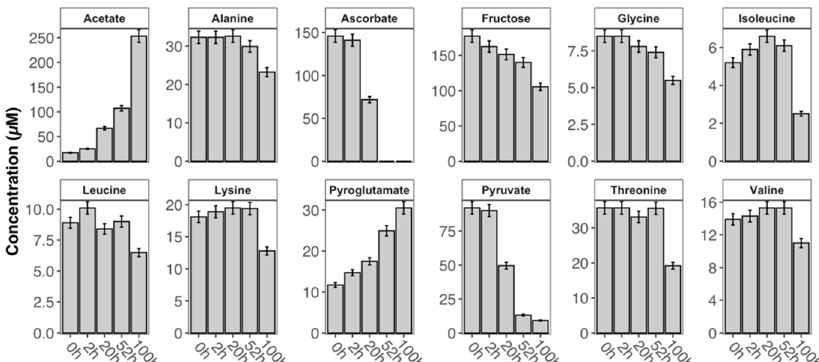
Figure 5. Time dependence of the relative concentration profiles of selected metabolites in the CSF sample ‘RT’ (error bars represent a 5% quantification uncertainty).